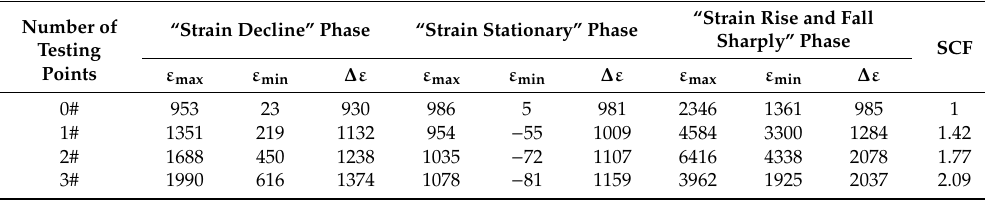
Table 5. Strain testing results ( µε